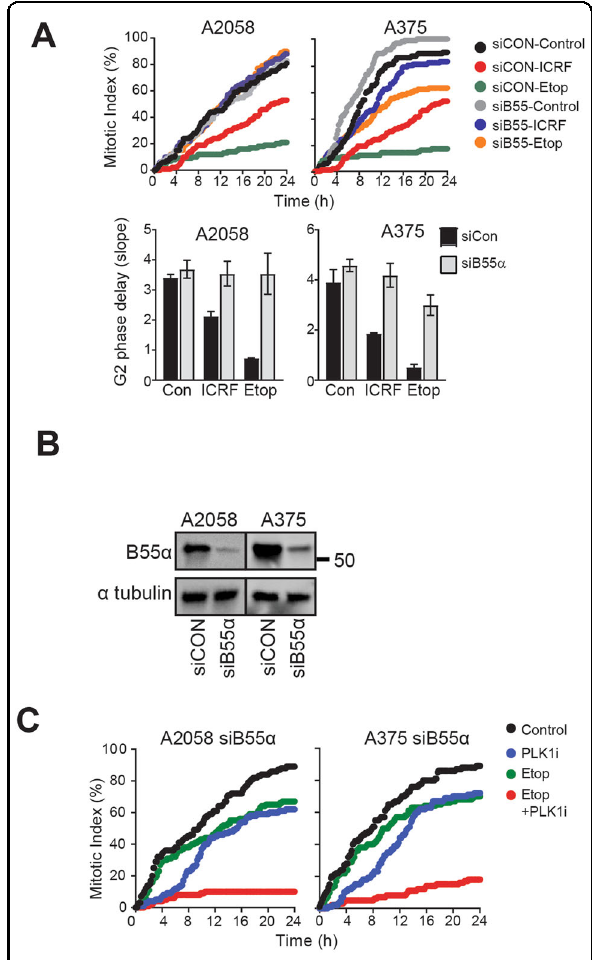
Fig. 4 Loss of PPP2R2A /B55 α overcomes Etoposide induced G2 checkpoint arrest. Asynchronously growing A2058 and A375 cells were transfected with either control or B55 α siRNA. A Transfected cells were treated with 5 μ M ICRF193 or 2 μ M etoposide, and the G2 phase delay was quanti fi ed using time lapse imaging. The data are from three independent experiments. B Cell lysates were immunoblotted with B55 α . α -Tubulin was used as a loading control. C siB55 α transfected cells were treated with 2 μ M etoposide, 500 nM BI2536 alone or in combination. G2 phase delay was quanti fi ed using time lapse